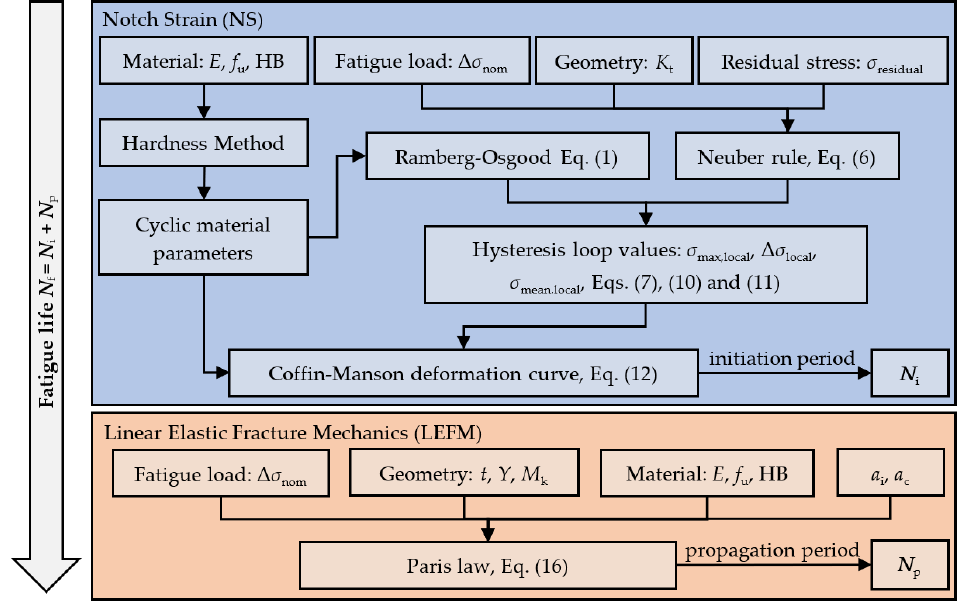
Figure 8. Flowchart of the